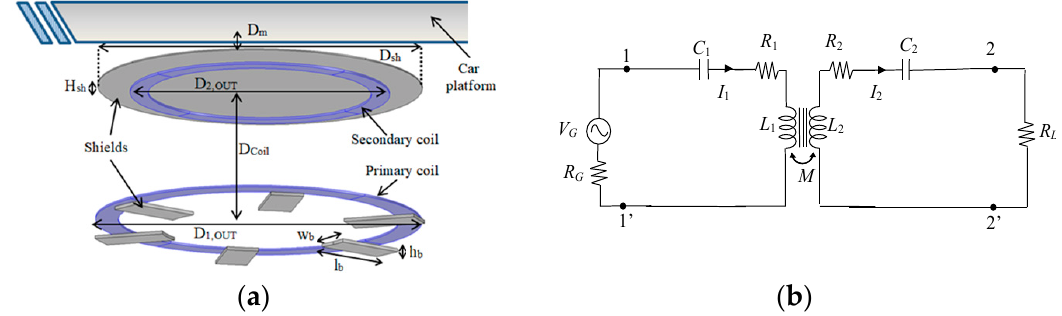
Figure 1. WPT coil configuration (primary coil on the road and secondary coil below the car platform) ( a ). WPT equivalent circuit ( b ).